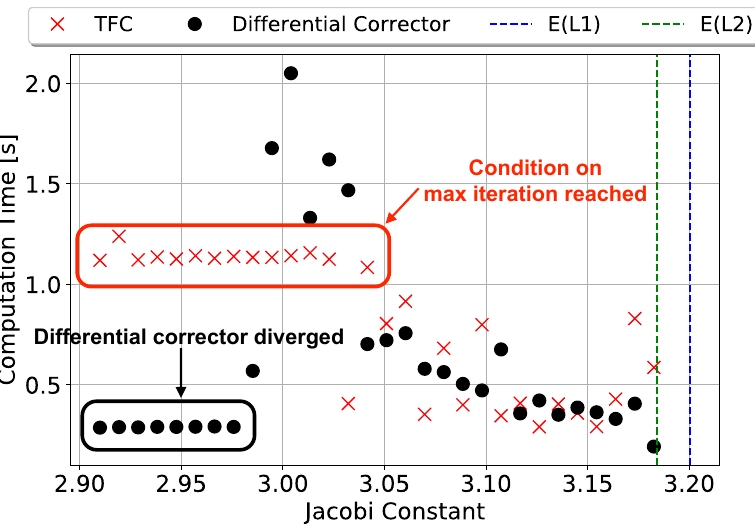
Figure 8. Computational time of the TFC method for the trajectories plotted in Figure 2b compared to that of the differential corrector. Again, the black box highlights where the differential corrector diverged. Additionally, the red box shows where the TFC method reached its maximum allowed iterations of 20. These cases are correlated to the reduction in accuracy seen in Figure